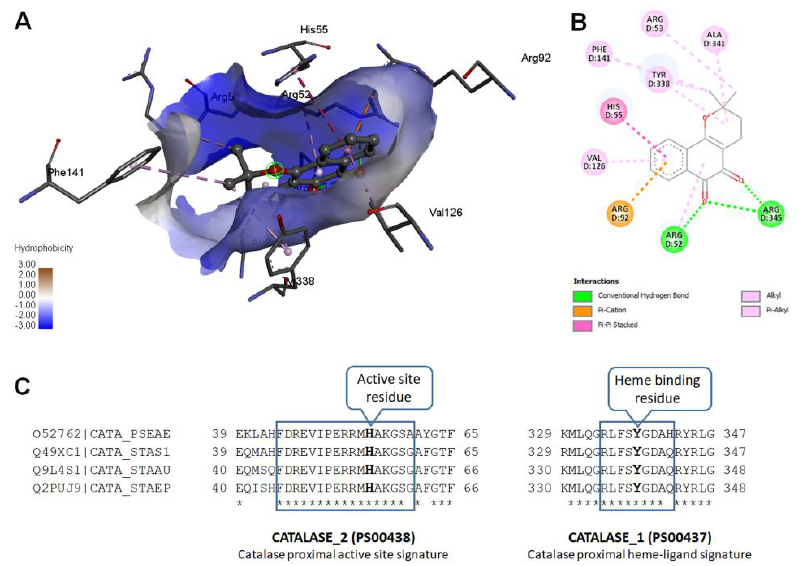
Figure 5. ( A ) Modeled Pseudomonas aeruginosa catalase (KatA tetramer, PDB code: 4e37) complexed with β-Lap. For clarity, only β-Lap (ball-and-stick presentation) interaction with one chain (4e37, chain D) of P. aeruginosa catalase is shown. ( B ) Modeled non-covalent interactions between β-Lap and KatA. ( C ) Alignments of the conserved ligand binding sites (PROSITE ACs: PS00437 and PS00438) of catalase (KatA) from Pseudomonas aeruginosa (UniProtKB AC: O52762), Staphylococcus saprophyticus (UniProtKB AC: Q49XC1), Staphylococcus aureus (UniProtKB AC: Q9L4S1), and Staph- ylococcus epidermidis (UniProtKB AC: Q2PUJ9). ; conserved residues